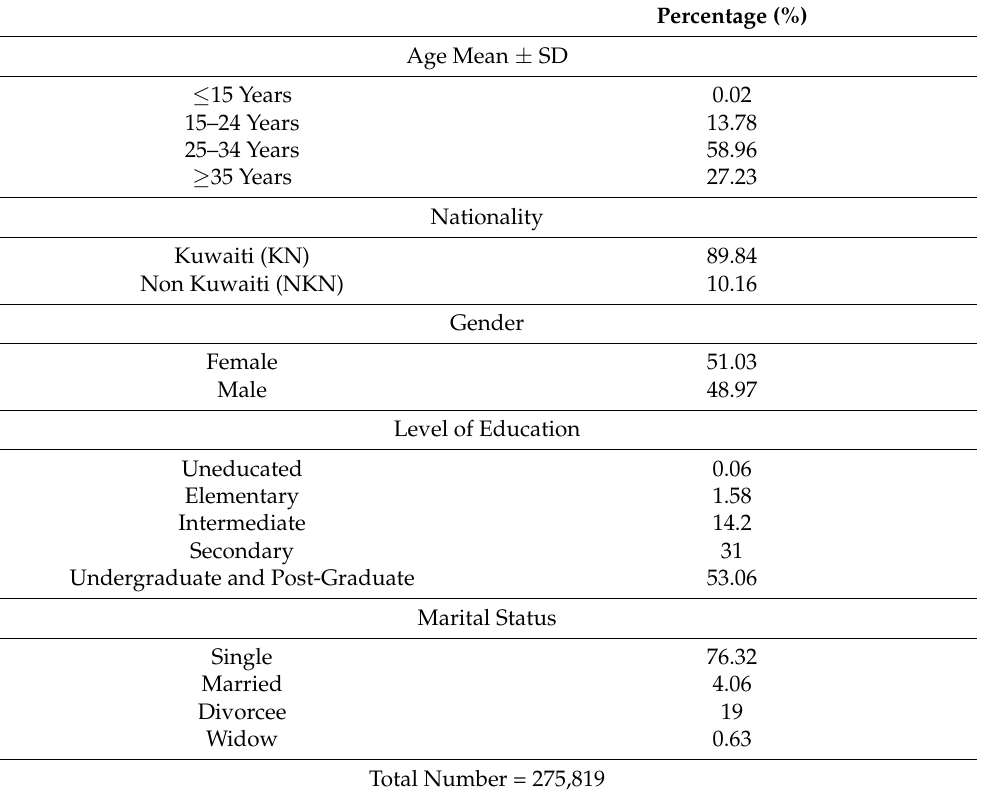
Table 1. Sociodemographic characteristics of the study